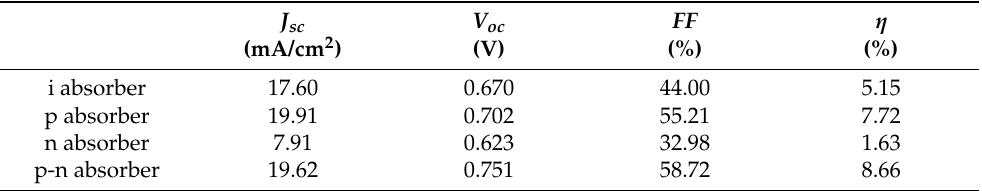
Table 4. Cell performance parameters of the four studied cases of the absorber layer.